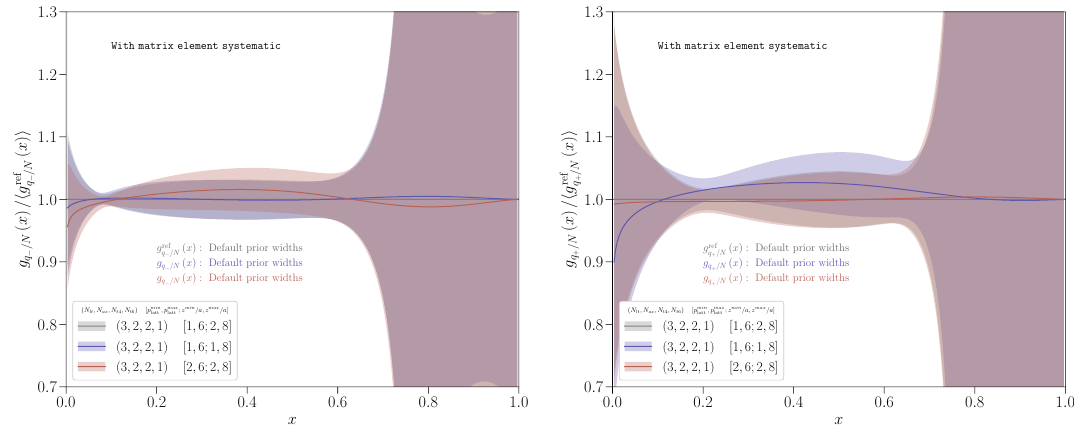
Figure 15 . Variability of extracted (left) g ( x ) and (right) g ( x ) PDFs when the reduced q − /N q + /N (cid:0) (cid:1) pseudo-ITD Y ν, z 2 is cut on p latt ∈ [1 , 6] , z/a ∈ [1 , 8] and p latt ∈ [2 , 6] , z/a ∈ [2 , 8] . The model ( N lt , N az , N t 4 , N t 6 ) = (3 , 2 , 2 , 1) is used for this comparison, and the matrix element fitting systematic remains in